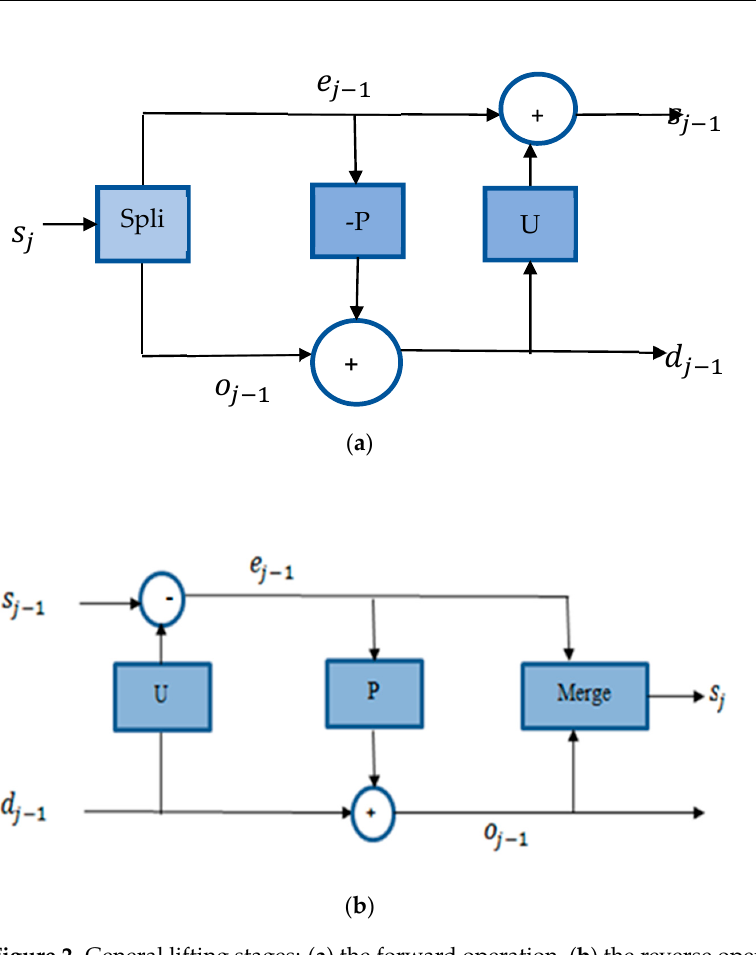
Figure 2. General lifting stages: ( a ) the forward operation, ( b ) the reverse operation.